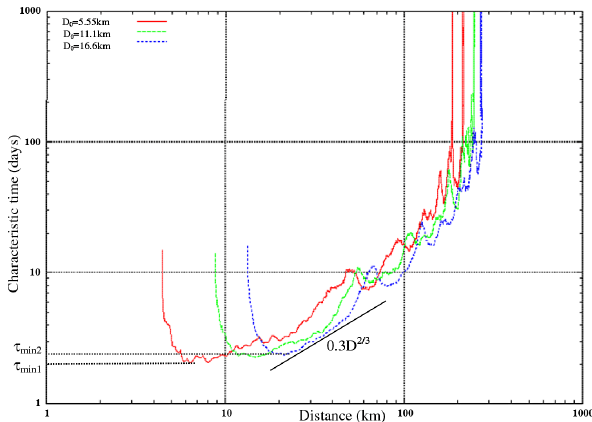
Fig. 6b. The zonal characteristic dispersion time τ x (D) = D 2 x /Y x as a function of D and D 0 . τ min1 = 2 days for D 0 = 5 . 55km and τ min2 = 3 days. The enstrophy varies between 0.44 and 1 days − 2 . The 0.3 D 2 / 3 curve is